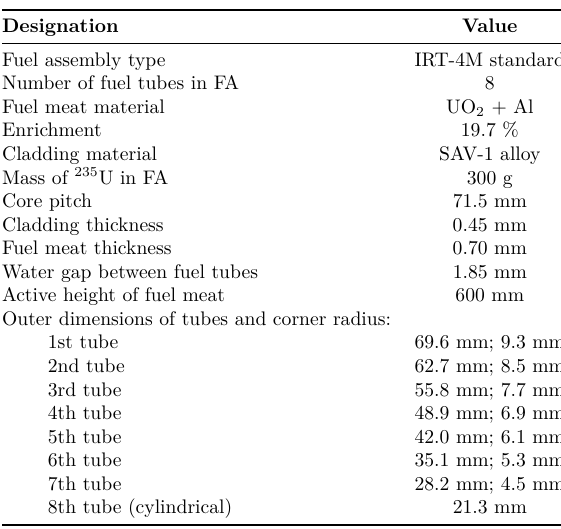
Table 1. Basic characteristics of standard IRT-4M fuel assembly